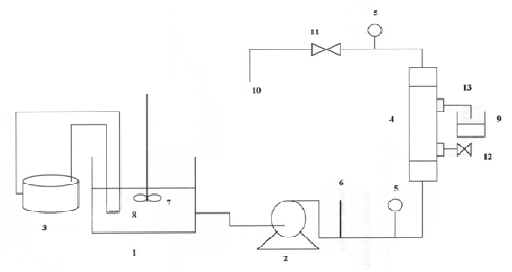
Fig.2. Schematic diagram of the apparatus setup. 1- Feed tank 2- Pump 3- Water bath 4- Hollow fiber membrane cartridge 5- Pressure gauge 6-Thermo-meter 7- Stirrer 8- Heating coil 9- Graduated flask 10- Retentate line 11- Control valve 12- Hose clamp, closed 13- Permeate